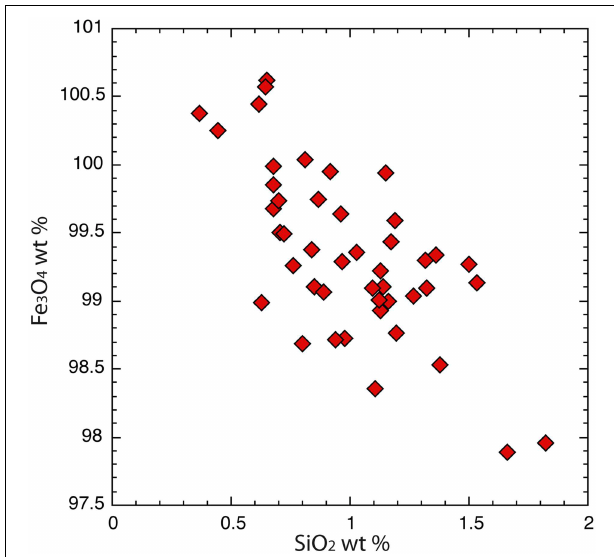
FIGURE 5 | Fe 3 O 4 and SiO 2 concentrations (in wt%) from microprobe analyses performed on more than 50 magnetite crystals in the BIF layers of sample 148.02.